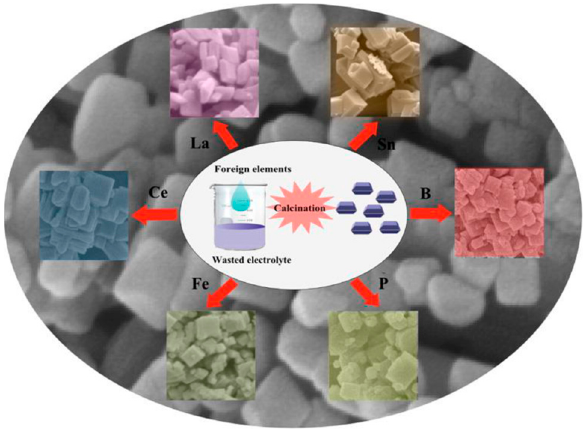
Figure 4. TiO 2 nanoparticles with different doping elements [2]. Copyright 2014 American Chemical Society.